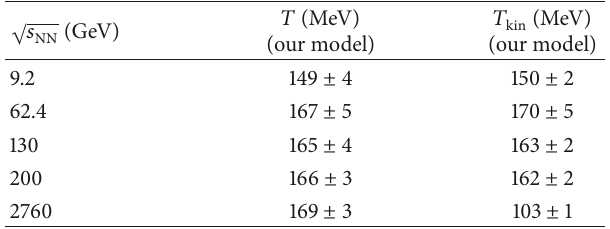
Table 2: The values of chemical and kinetic freeze-out temperatures obtained at different collision energies in our